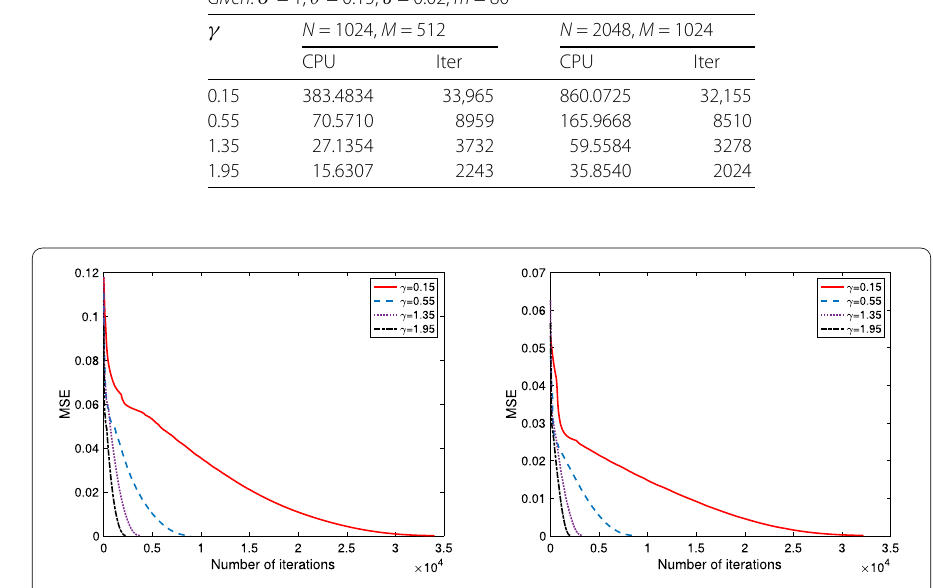
Figure 3 Graphs of MSE value and number of iterations when N = 1024, M = 512 and N = 2048, M = 1024